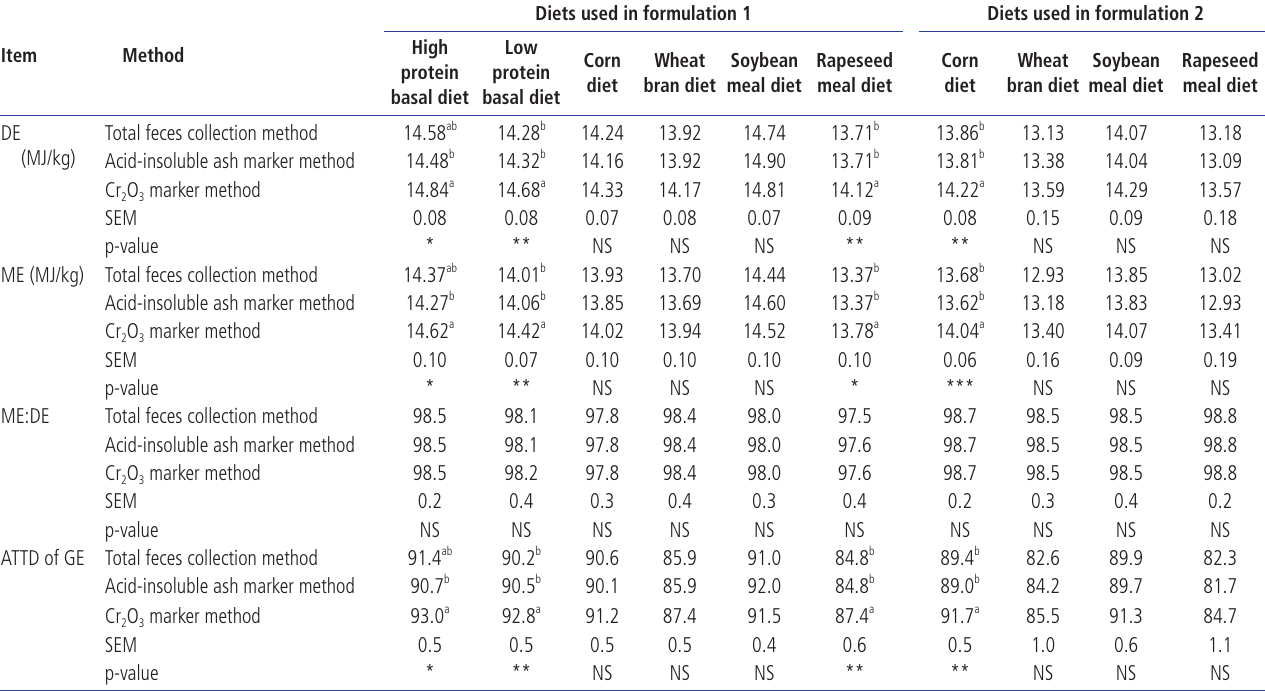
Table 5. Effects of different methods on digestible energy (DE), metabolizable energy (ME), and the apparent total tract digestibility (ATTD) of gross energy (GE) in experimental diets fed to growing pigs (% as-fed basis) 1)